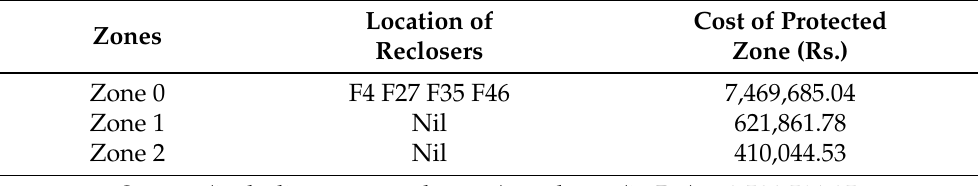
Table 7. Optimized placement of reclosers in three islands/zones of 69-bus RDS illustrated in Figure 5.